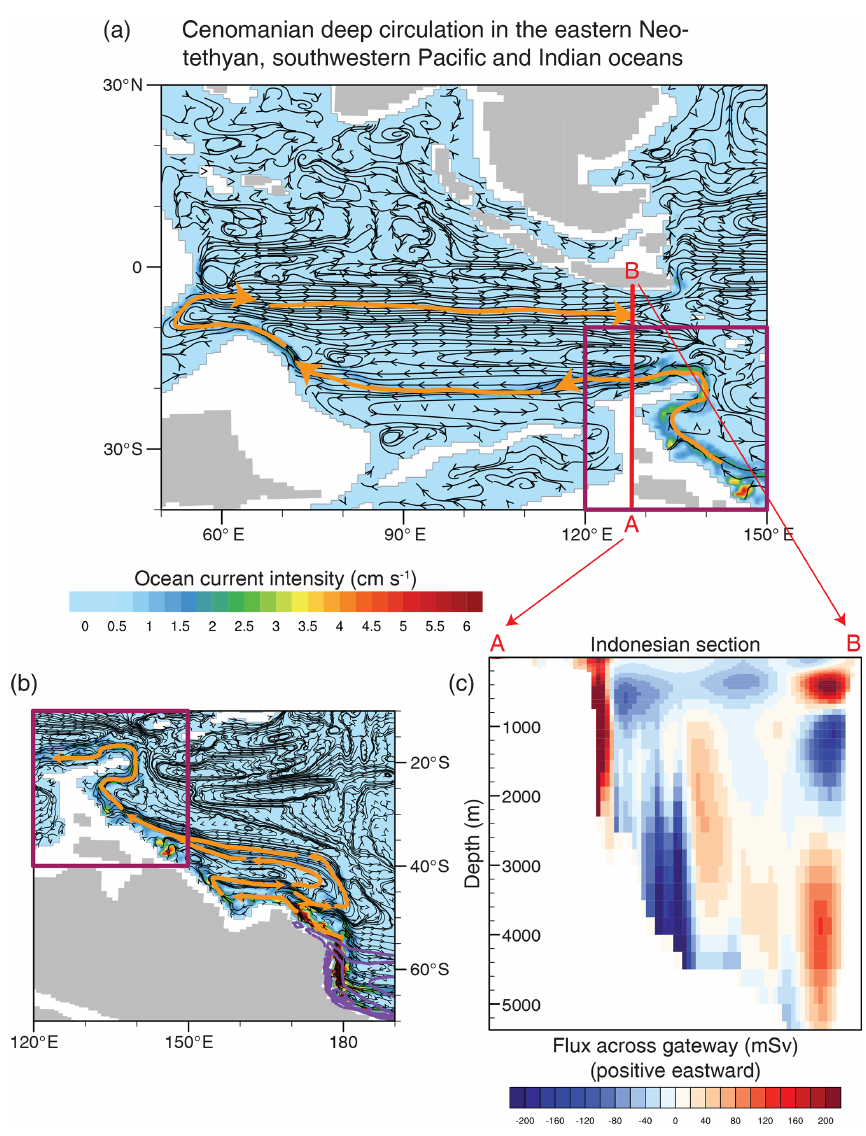
Figure 7. Cenomanian deep circulation (3000m) in (a) the eastern Neotethyan Ocean and (b) the southwestern Pacific Ocean. Orange arrows represent major deep current systems in the eastern Neotethyan Ocean and southwestern Pacific Ocean. Purple contours represent regions of deep waters formation (contour 500m). Section A–B defines the Indonesian section of Table S1. (c) Fluxes of water across the Indonesian section over the whole water